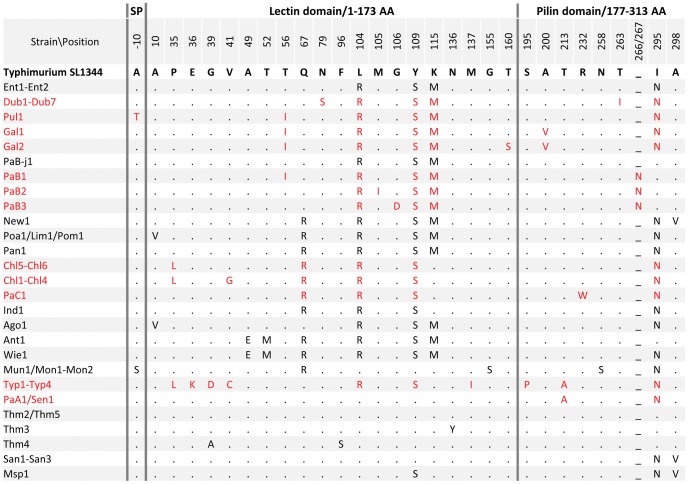
Amino acid variation in S. enterica subspecies I FimH.Residues identical to the amino acid sequence of S. Typhimurium SL1344 (Thm1) FimH are indicated by dots. Systemically invasive serovars are shown in red and non-invasive serovars are shown in black. Position -10 represents the position in the signal peptide of unprocessed FimH upstream of the cleavage site.